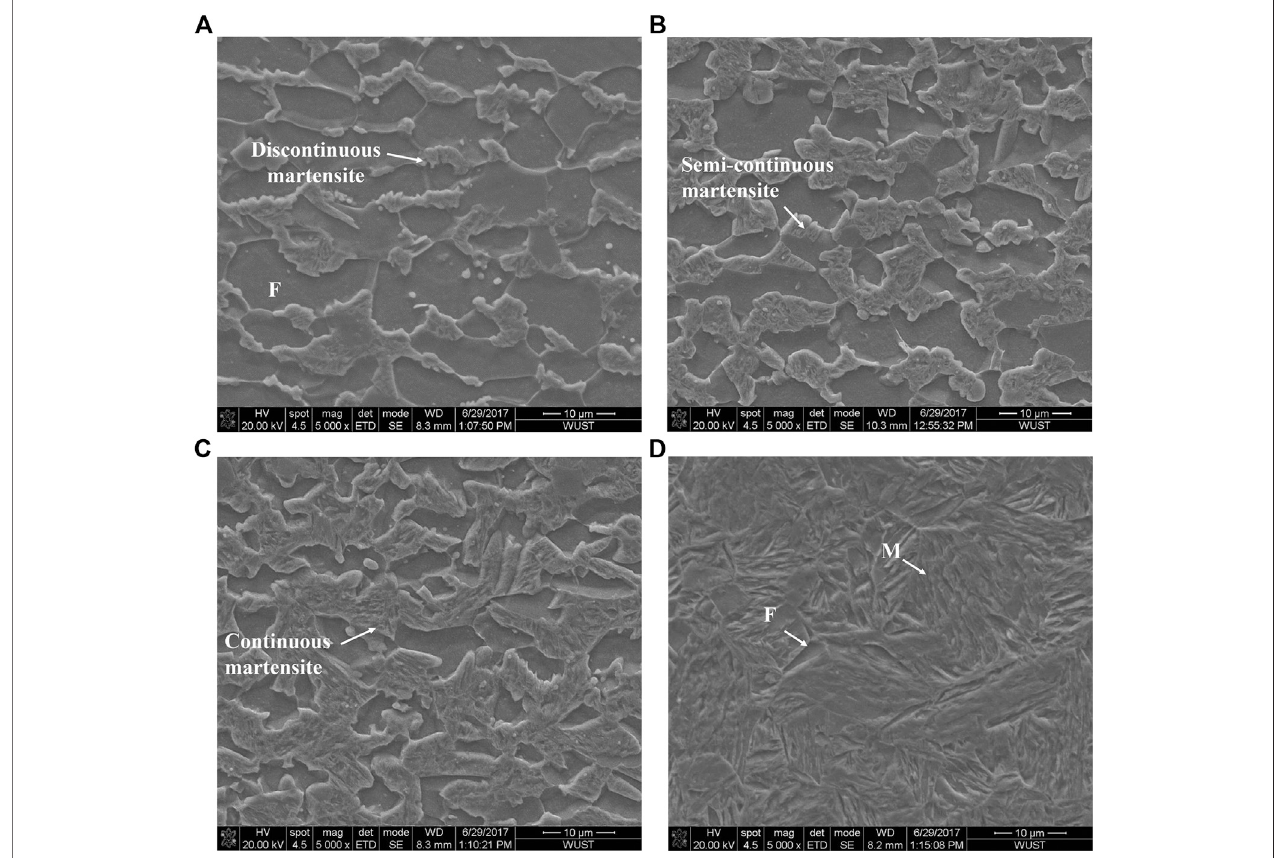
FIGURE 2 | SEM images of DP steels after annealing at (A) 780 ° C; (B) 810 ° C; (C) 840 ° C; and (D) 870 ° C.